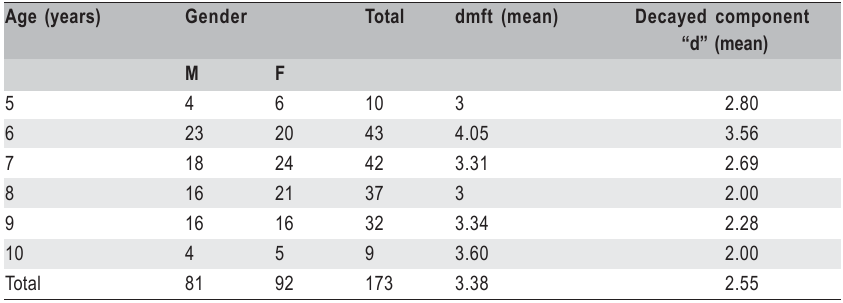
Table 2. Distribution of children by age, gender, mean dmft and “decayed” component in the173 schoolchildren participating in the study.